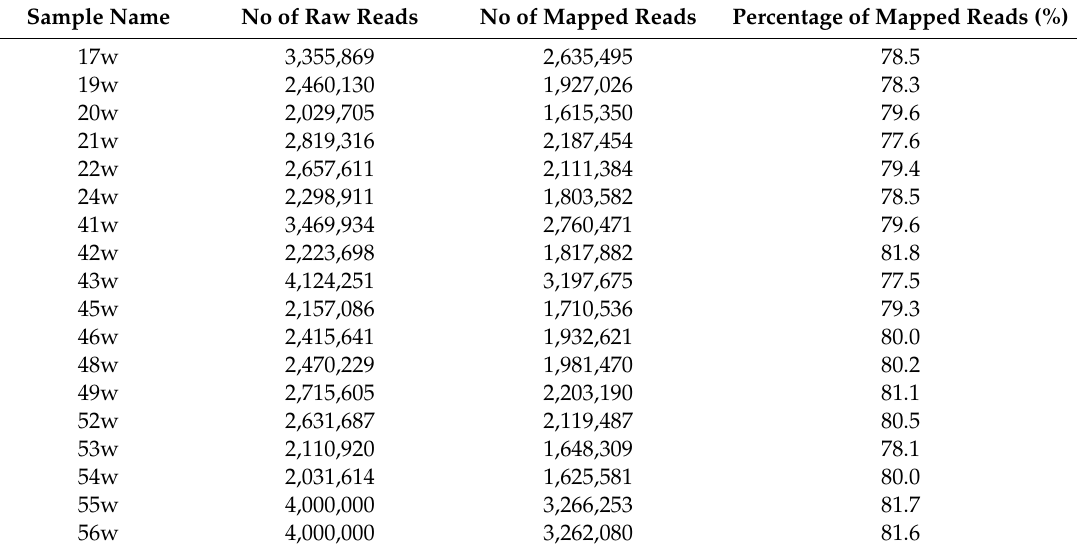
Table 1. RNA-seq statistics of Quant-seq 3 (cid:48) mRNA-sequencing.